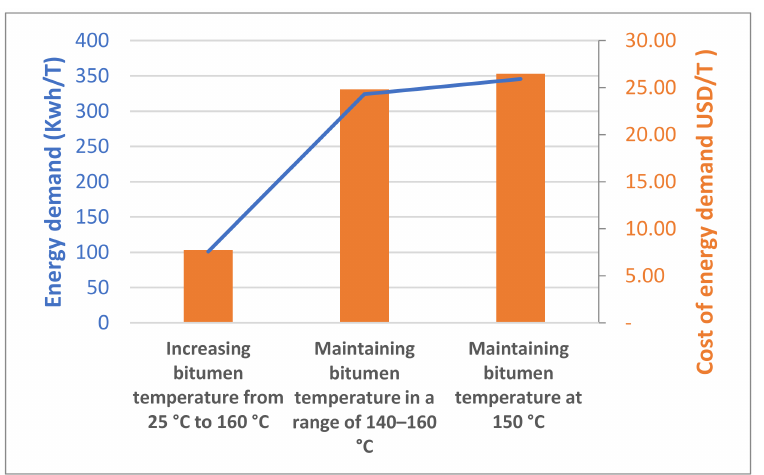
Figure 13. Different storage scenarios: Increasing bitumen temperature from 25 ◦ C to 160 ◦ C, maintaining bitumen temperature in a range of 140 ◦ C and 160 ◦ C, and maintaining bitumen temperature at 150 ◦